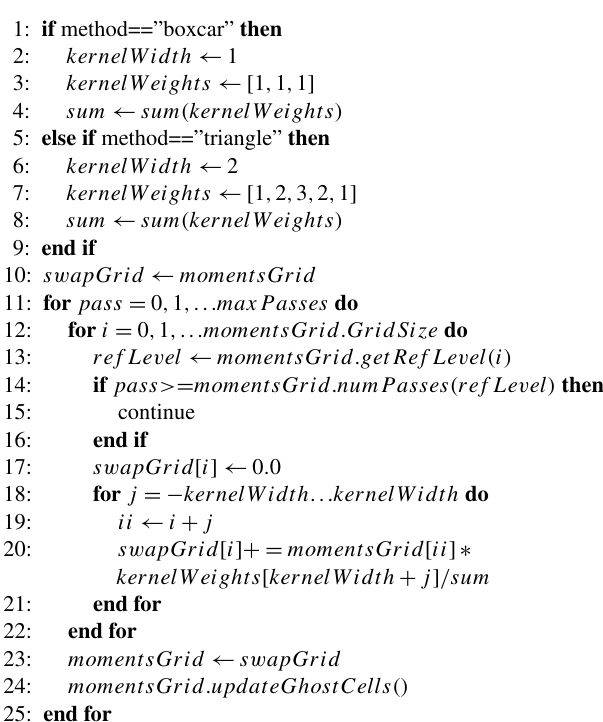
Figure 1. (a) Perspective 3D view of the AMR Vlasov grid. Here, the Earth is located at the axes’ origin. (b) Equatorial distribution of the AMR refinement levels on the Vlasov grid in a 3D AMR simulation. Refinement level n corresponds to 2 n times the base resolution. Darker regions closer to the Earth ( n = 3) are solved with the highest spatial resolution used in the simulation. Algorithm 1 Filtering operator